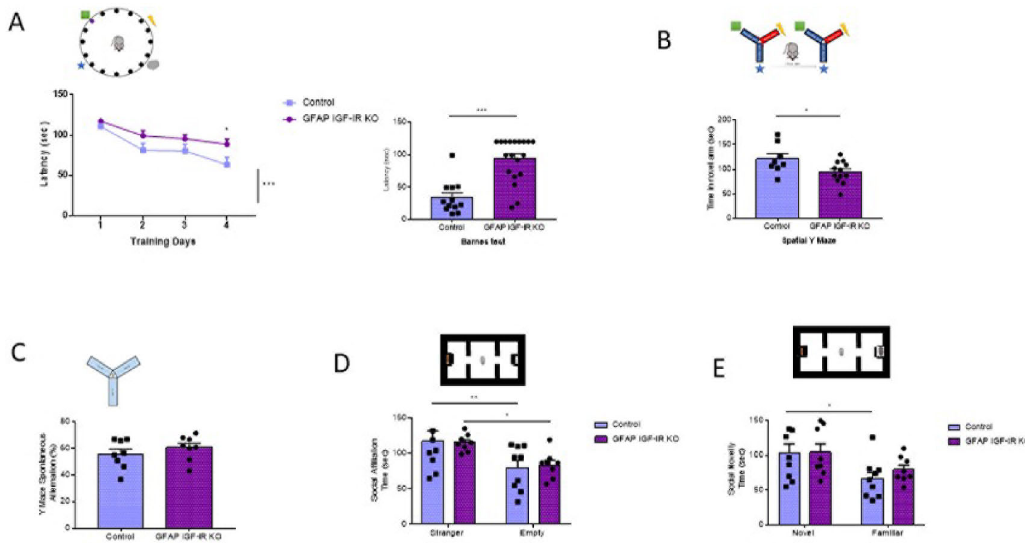
Figure 3. Cognitive traits in mice lacking IGF-I receptors (IGF-IR) in GFAP astrocytes (GFAP-IGF-IR KO mice). A, Spatial learning in the Barnes maze (upper drawing) was markedly affected in GFAP IGF-IR KO mice, showing significantly reduced memory (control n= 12, GFAP IR KO n=19, training days: 2-way ANOVA, time factor, F(3,122)= 12.7; ***p<0.001, Sidak's multiple comparisons test, control vs GFAP 4 th day of training, *p<0.05; test day: Mann- Whitney U: 21.5, ***p<0.001). B, Time spent in the novel arm of the Y maze (upper drawing), a measure of spatial memory,wasreduced inGFAPIGF-IR KOmice(controln=8,GFAPIGF-IR KOn=12,t-test, t=2.26,*p<0.05).C, Number of spontaneous alternations in a Y maze, a measure of working memory (upper drawing), was similarly unaltered in adult GFAP IGF-IR KO mice (n=8 per group; t-test; t=0.98, p=0.342). D, Social affiliation, as determined by time spent withastrangermousevsanemptycage(upperdrawing),wasnormalinGFAPIGF-IRKOmice(controln=9,GFAPIGF- IR KO n=8, 2-way RM ANOVA, condition factor, F(1,15)=19.13; ***p<0.001, Sidak's multiple comparisons test, control familiarmicevsemptycage,**p<0.01,GFAPIRKOfamiliarvsemptycage,*p<0.05).E,Socialnovelty,asmeasuredby time spent with a novel partner (upper drawing), was impaired in GFAP IGF-IR KO mice (control n=9, GFAP IGF-IR KO n=8, 2-way RM ANOVA, condition factor, F(1,15)=11.18; **p<0.01, Sidak's multiple comparisons test, control novel